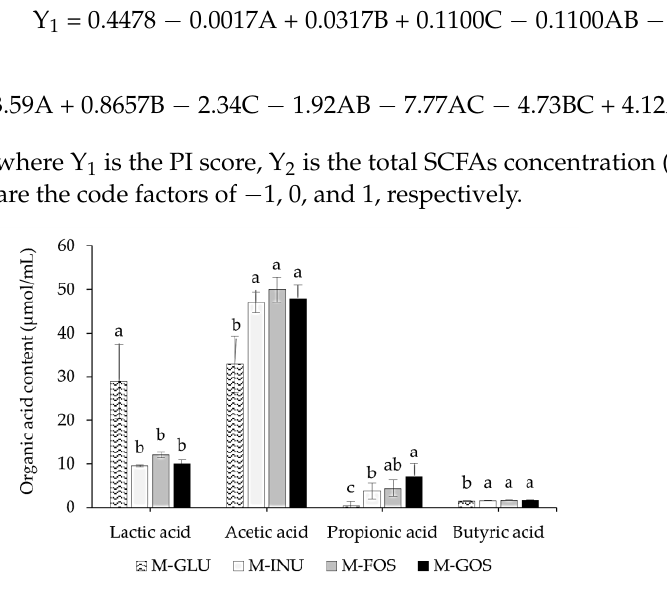
Figure 5. The organic acid concentration: lactic acid, acetic acid, propionic acid, and butyric acid, of co-culture bacterial strains in the different mediums supplemented with glucose (control) and prebiotics, for which the various letters showed a significant mean difference ( p < 0.05) in each type of organic acid. Table 2. The actual and predicted values of the PI score and total SCFAs for the mixed prebiotics following the run of a Box–Behnken design